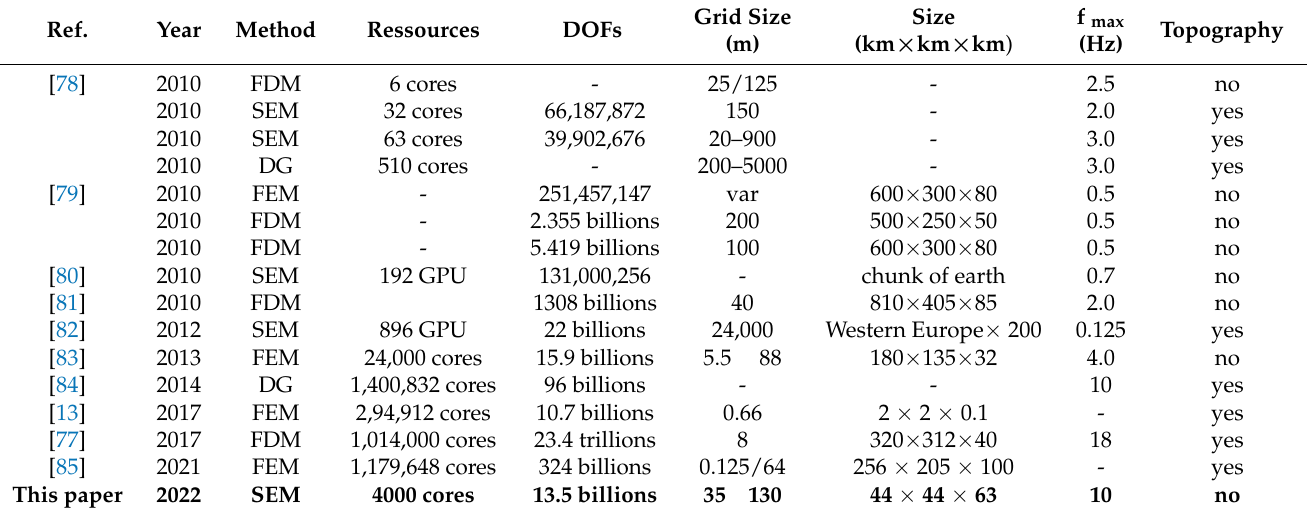
Table 1. Summary of major time-domain, large-scale simulations of seismic waves in the last 10 years (table after [24]). FDM: Finite Different Method, FEM: Finite Element Method, SEM: Spectral Element Method, DG: Discontinuous Galerkin. “-” indicates that the desired data are not available in the reference. This table is not